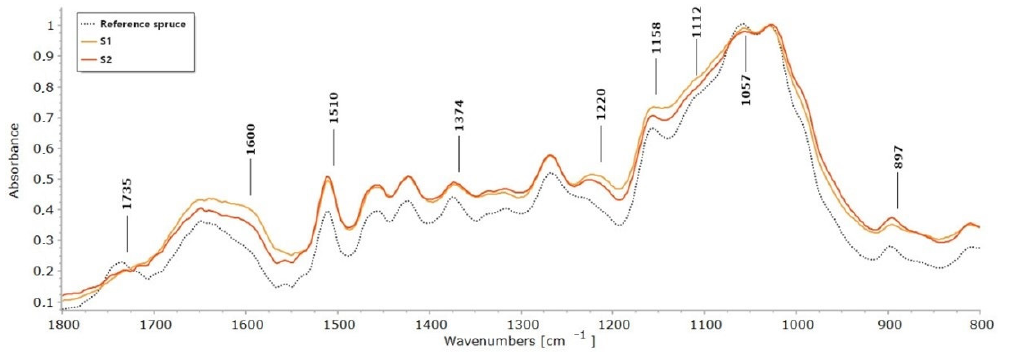
Figure 2. FTIR spectra of archaeological spruce wood samples and reference spruce wood sample.